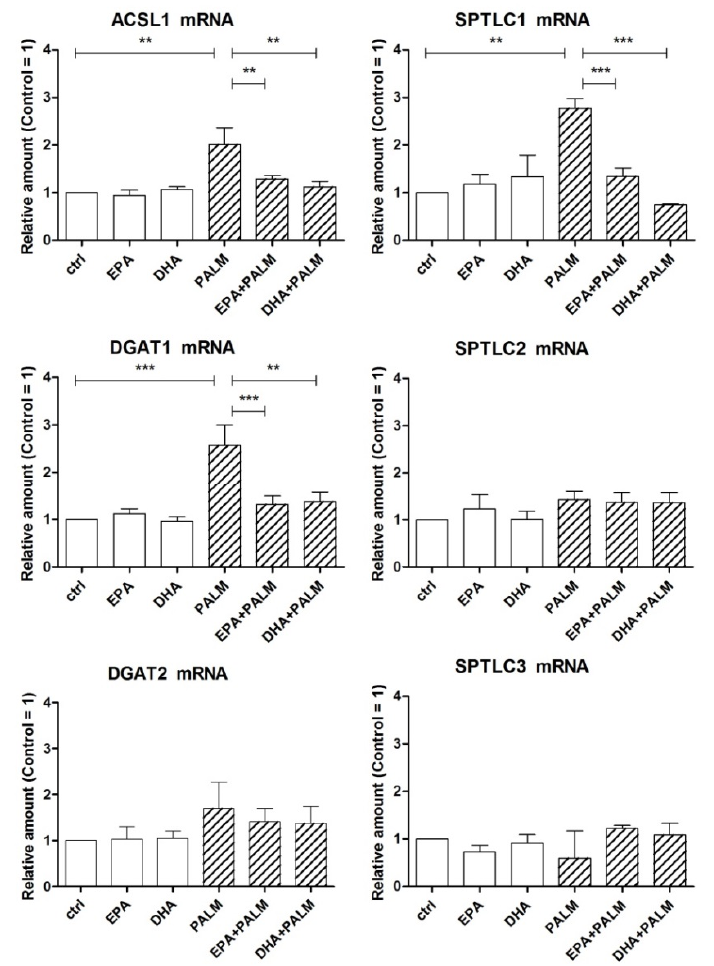
Figure 3. Effect of n-3 PUFAs on the expression of genes coding for key enzymes related to fatty acid metabolism in H9c2 cells exposed to palmitate. H9c2 cells were incubated in the presence or absence of fatty acids as described in the legend of Figure 1. After a 16 h incubation, H9c2 cells were analyzed by RT-PCR for the relative amount of ACSL1 mRNA, DGAT1 mRNA, DGAT2 mRNA, and SPTLC subunit mRNAs. Differences are indicated with ** or *** for p < 0.01 and p < 0.001, respectively.